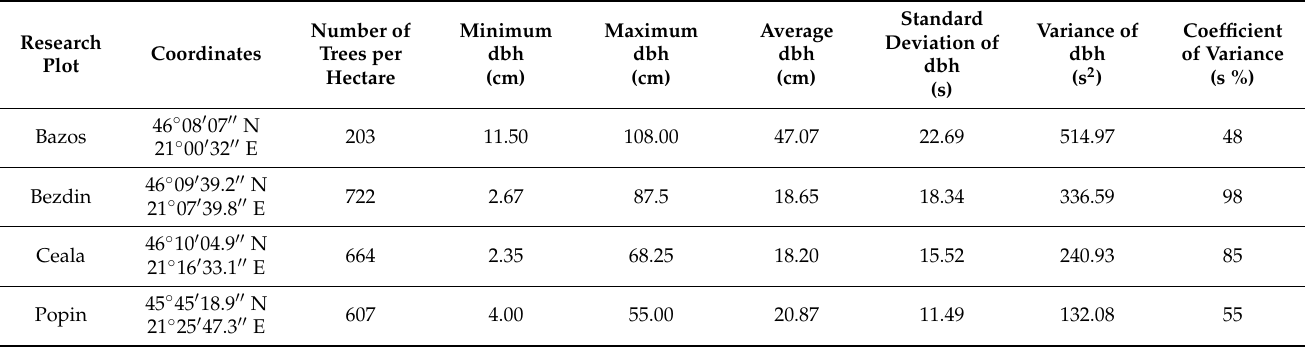
Table 1. Descriptive statistics of